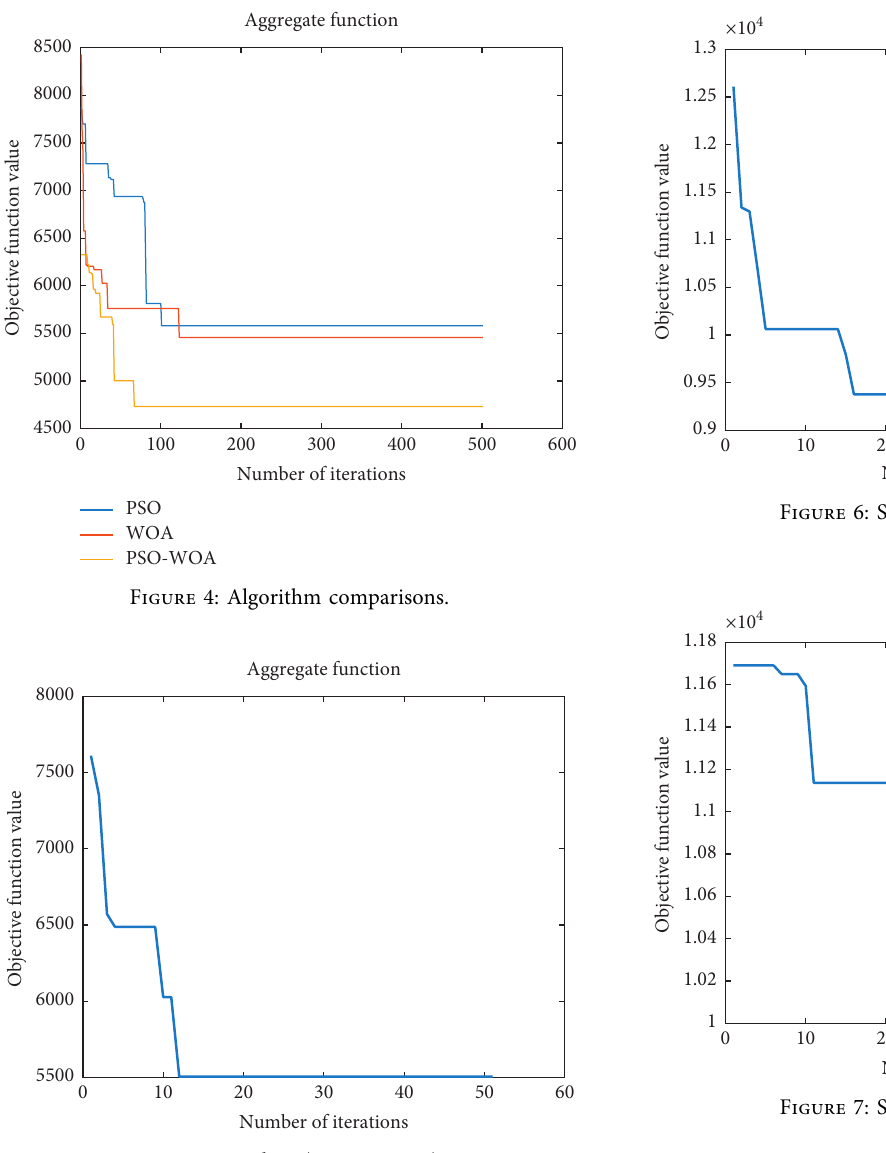
Figure 5: Scale 1 (25 customers).